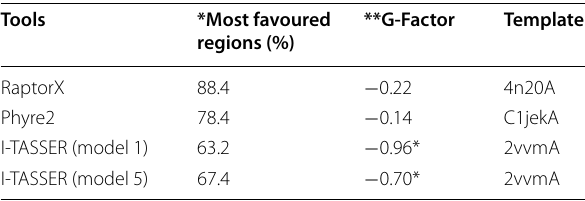
Table 4 PROCHECK statistics of Y-domain 3D structures obtained using different tools